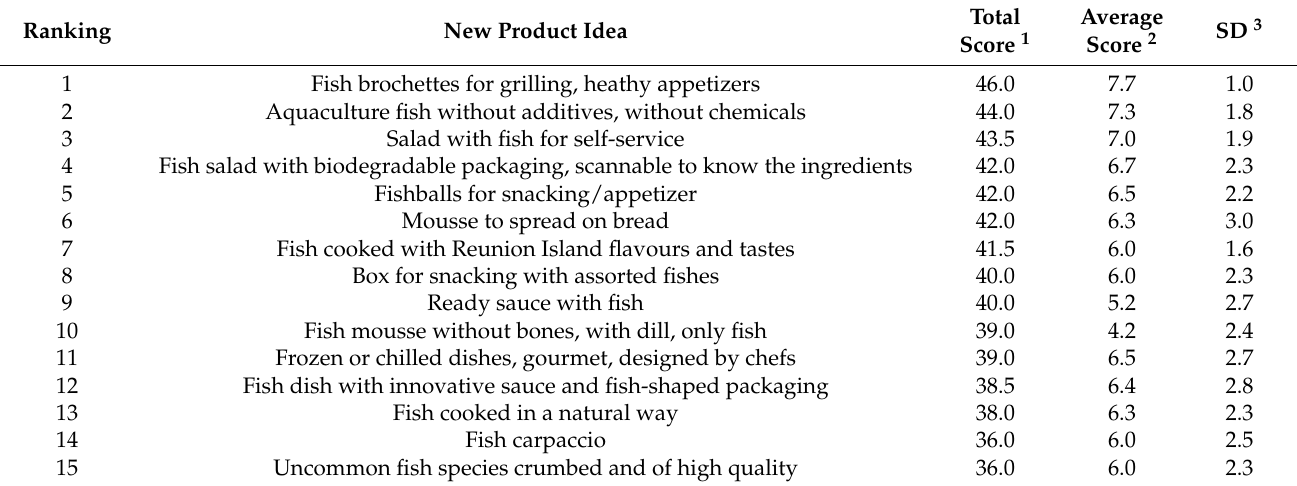
Table A1. Ranking of ideas with higher participant acceptability in